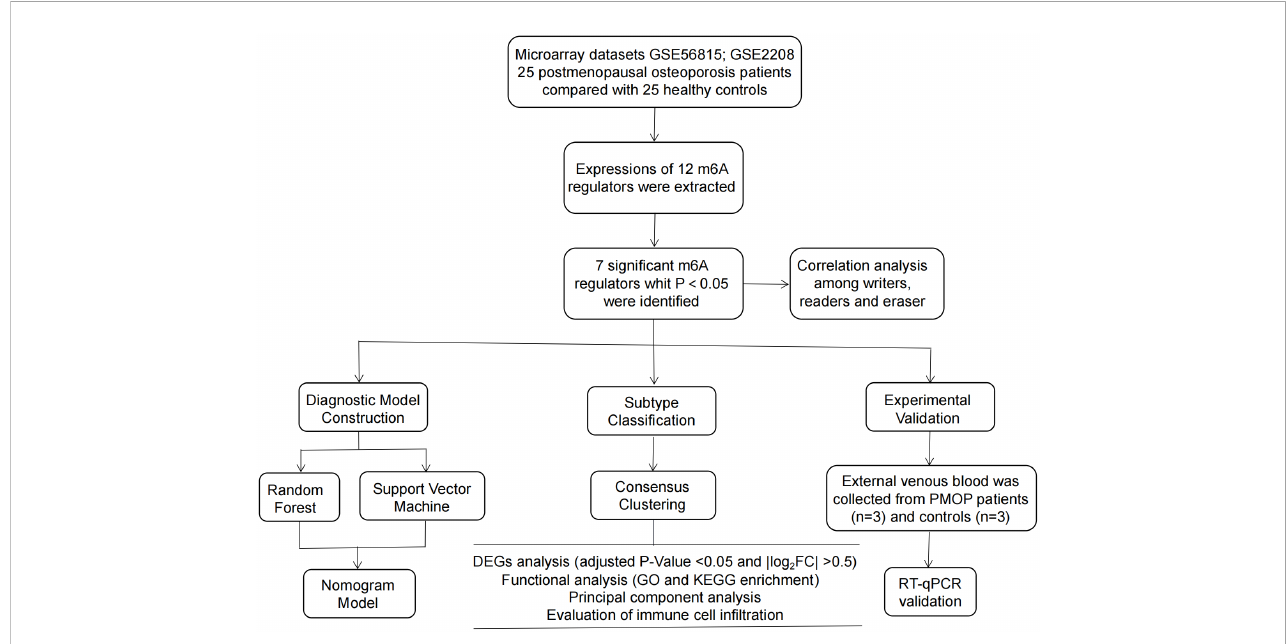
FIGURE 1 Flow chart of the study